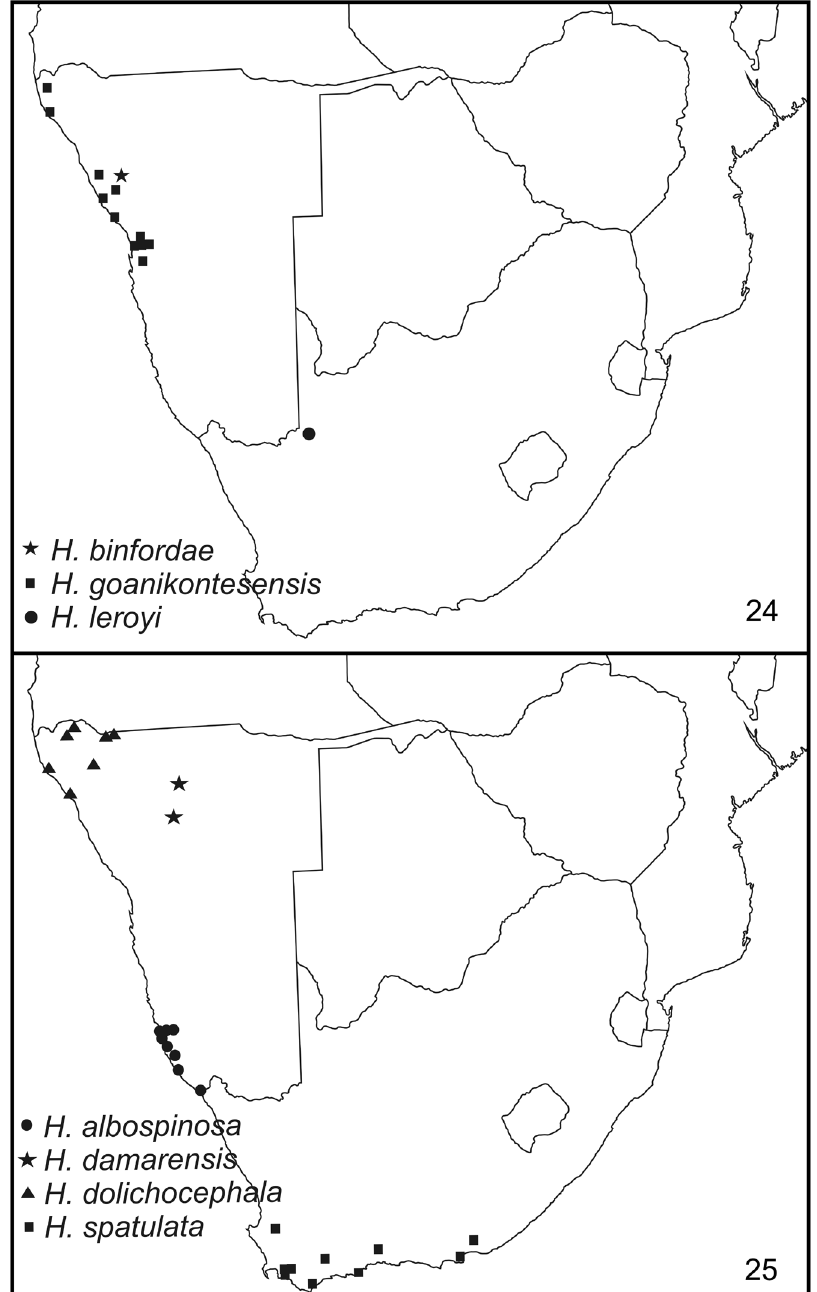
Figs 24–25. Distribution maps for species of Hexophthalma Karsch, 1879. 24 . H. goanikontesensis sp. nov., H. binfordae sp. nov. and H. leroyi sp. nov. 25 . H. albospinosa (Purcell, 1908, H. damarensis (Lawrence, 1928), H. dolichocephala (Lawrence, 1928) and H. spatulata (Pocock,